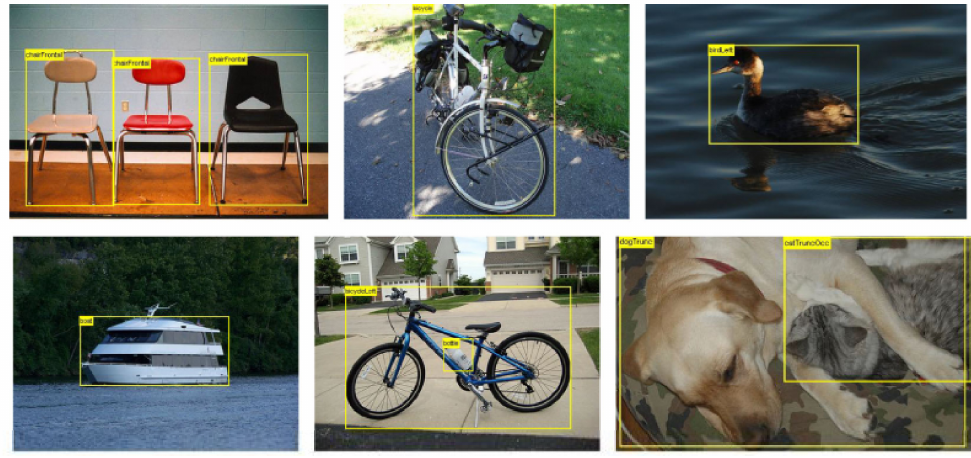
Figure 6. Annotation samples of the PASCAL VOC dataset, which is mainly used for natural object detection.